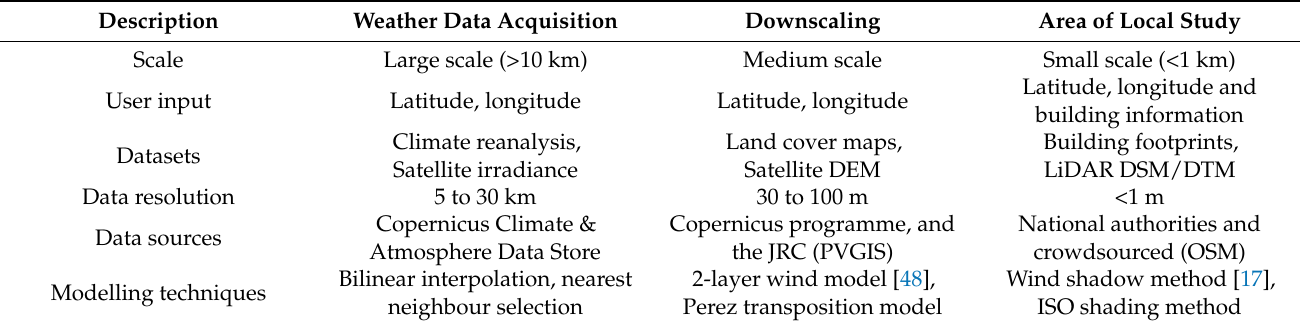
Table 1. An overview of open geospatial data sources that cover different spatial scales.